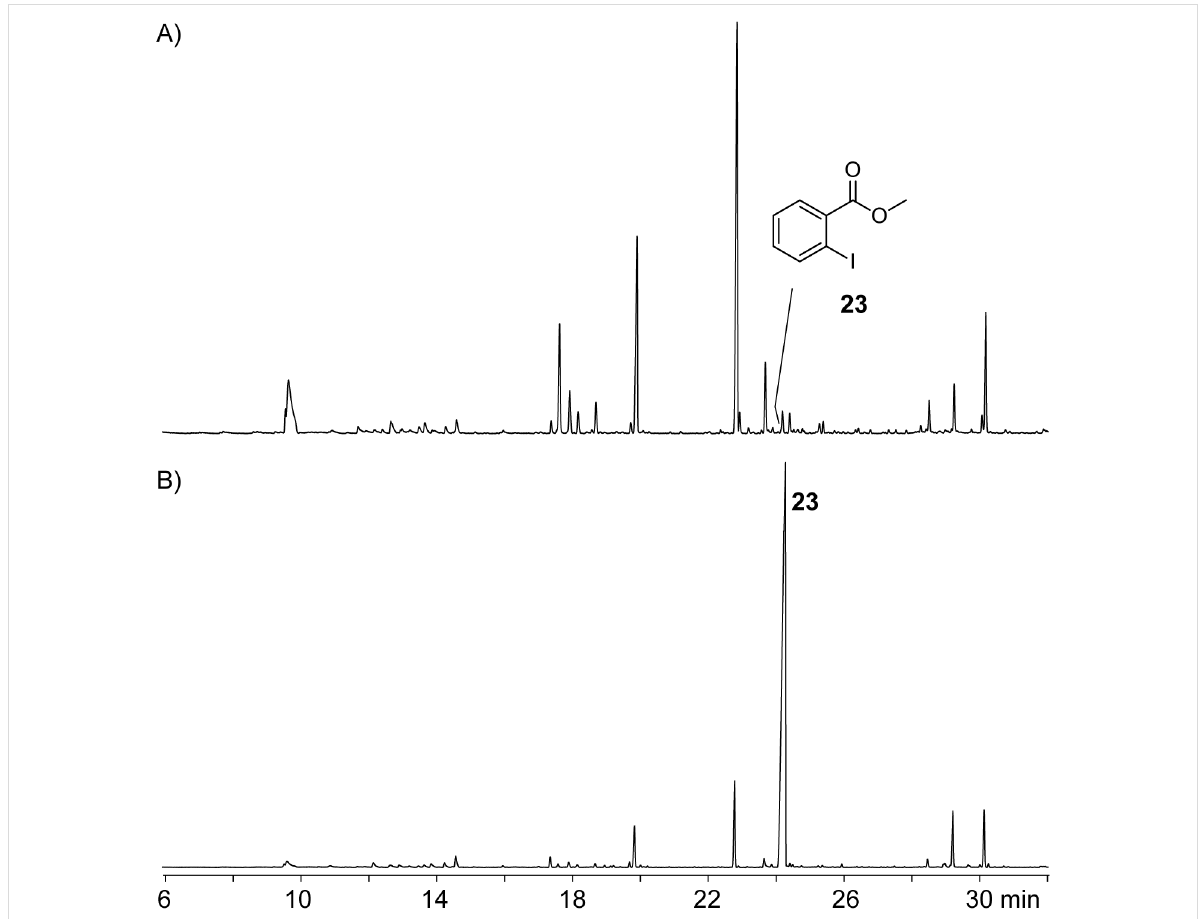
Figure 6: Total ion chromatograms of headspace extracts from S. chartreusis . A) Growth on 84 GYM showing production of 23 as a trace compound. B) Growth on 84 GYM amended with 2-iodobenzoic acid (1 mM) results in the emission of 23 as the principal volatile compound.